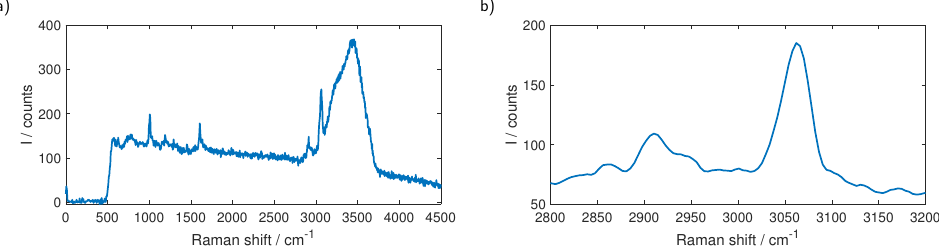
Figure 6. ( a ) Raman spectrum of a single PS sphere with 101 µm diameter. The relevant lines for the differentiation of different types of plastic are between 2800 cm − 1 and 3200 cm − 1 for 532 nm excitation and partly hidden in the broad Raman response of water. ( b ) The same measurement after subtracting the background and smoothing the data with a Savitzky–Golay filter. The relevant Raman lines of PS at 2855 cm − 1 , 2907 cm − 1 and 3058 cm − 1 are visible.